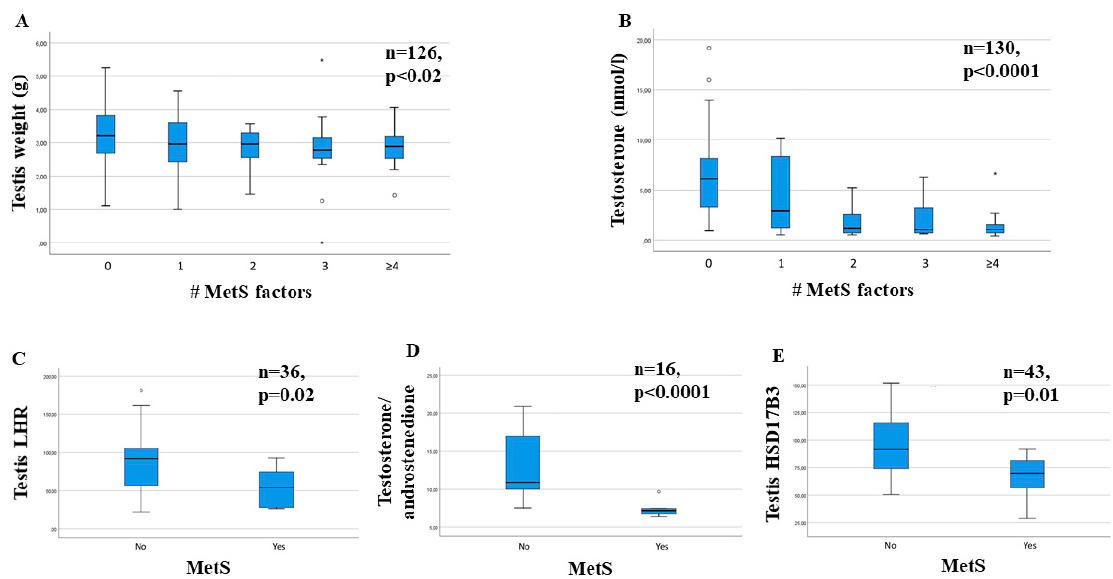
Figure 4. Effect of high-fat diet (HFD)-induced metabolic syndrome (MetS) on testicular weight and function. ( A ) and ( B ) show the dose-dependent effect of having the indicated numbers of MetS components on testis weight and circulating testosterone, respectively ( C , D , E ) show the effect of MetS, as a dummy variable, on testicular expression of the LH receptor (LHR), testosterone/androstenedione ratio and expression of the genes for the enzyme 17 β -hydroxysteroid dehydrogenase 3 (HSD17B3), respectively. Numbers of animals examined ( n ), along with level of significance ( p value) of the statistical analyses performed are also reported; g, grams. #, number. * and ◦ , outlier